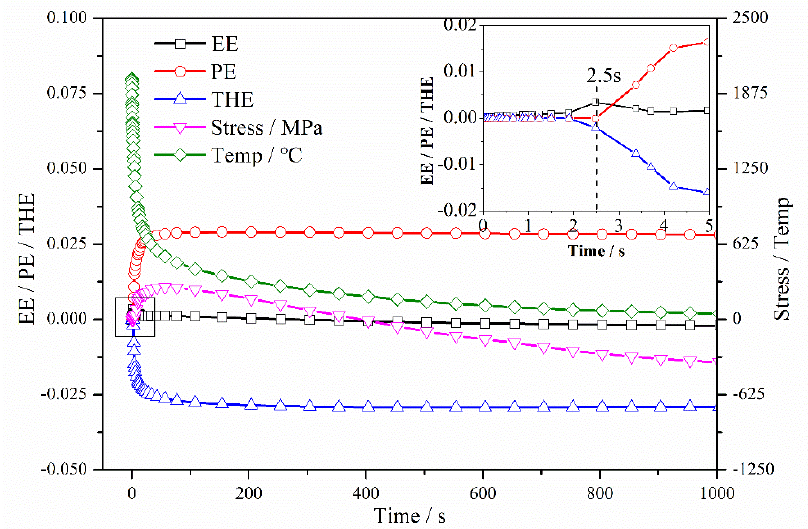
Figure 12. Temperature, strain, and WRS evolution in first half of cooling for elements in cladding layer at 1.75 mm (EE, elastic strain; PE, plastic strain; THE, thermal strain; Stress, WRS; Temp, temperature).